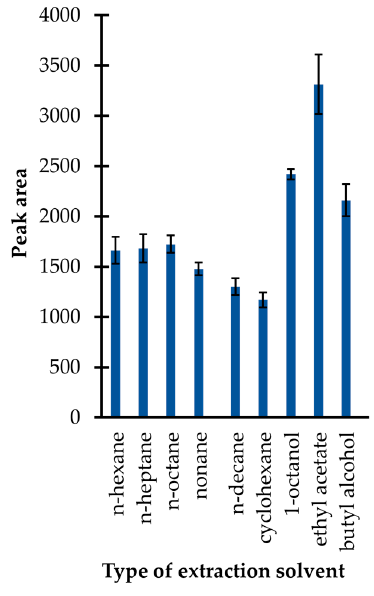
Figure 4. Extraction efficiency of the isobutyl derivative of 1,3-thiazinane-4-carboxylic acid (TCA- IBCF) as a function of the type of extraction solvent expressed as a peak area of the derivative. Samples were analyzed according to the procedure described in Section 3.6. Error bars refer to the standard deviation (SD) of the data ( n = 3).